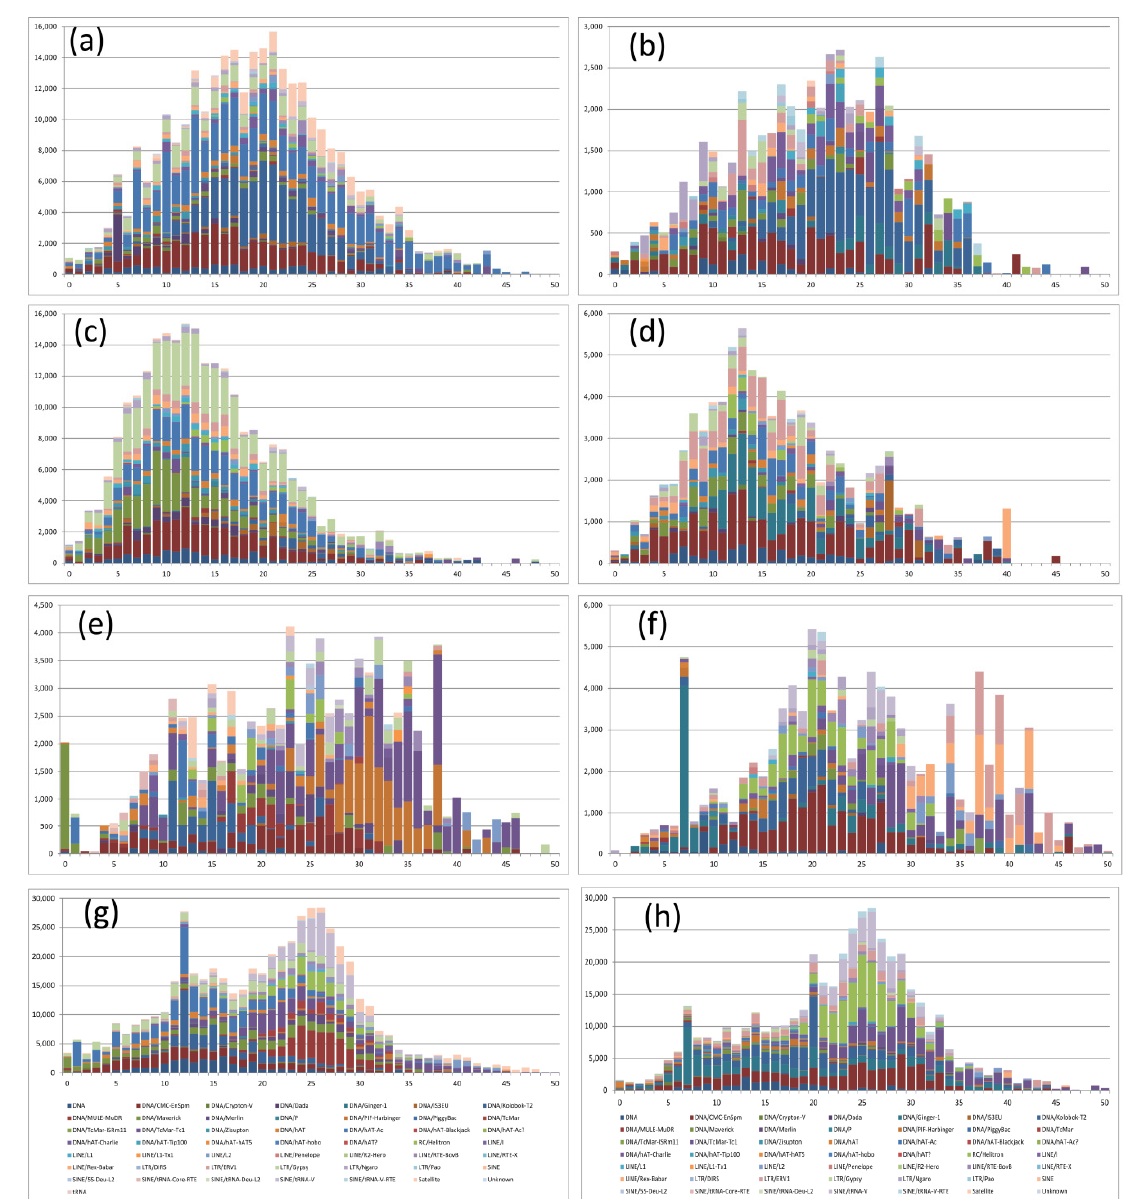
Figure 7. Kimura distance-based copy divergence analysis of transposable elements of chromosomes 2 and 4 of Solea senegalensis compared with their syntenic regions in other reference fish species. Graphs represent genome coverage (y axis) for each type of TE in the different genomes analyzed, clustered according to Kimura distances to their corresponding consensus sequence (x axis, K-value from 0 to 50). Graphs ( a , c , e , g ) show results from chromosome 2; and graphs ( b , d , f , h ) from chromosome 4. Rows are: Cynoglossus semilaevis ( a , b ), Scophthalmus maximus ( c , d ), Oryzias latipes ( e , f ) and Danio rerio ( g , h ) .